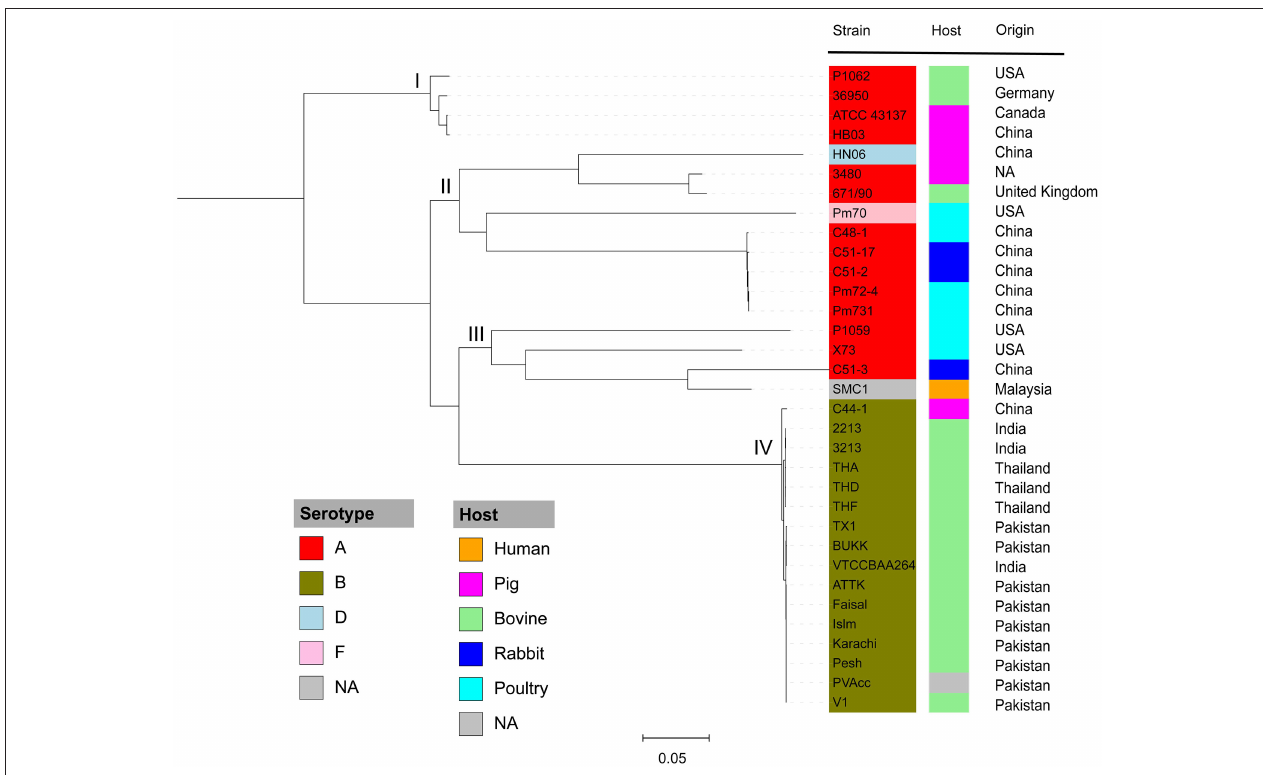
FIGURE 2 | Maximum likelihood phylogeny of P. multocida . The phylogenetic tree was reconstructed based on SNPs in the core genomes of P. multocida strains using the Parsnp program (Treangen et al., 2014). Phylogenetic group was manually set and designated as groups I, II, III, and IV. All strains are color-coded according to their serotypes A, B, D, and F. The host origin of each strain is denoted by the right color strip with the same scheme as in Figure 1 . The geographical location of isolation for each strain is shown. The gray box labeled as NA indicates the metadata is not available for the related